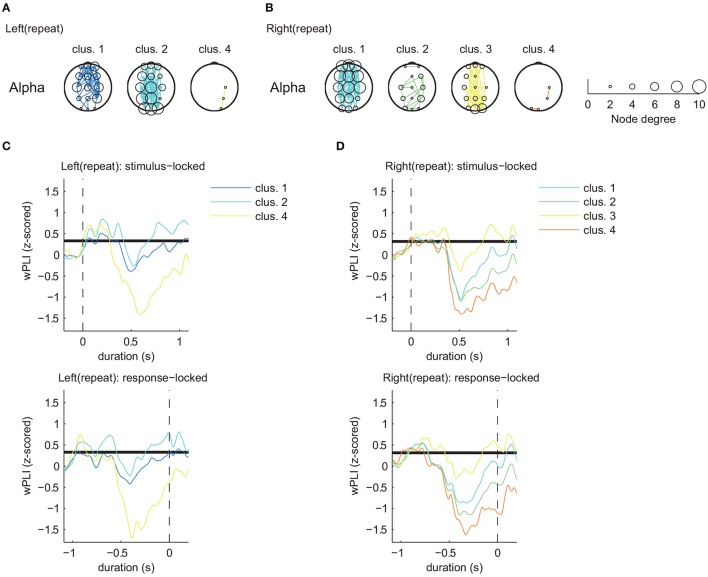
Estimated clusters and functional connectivity based on time series matching of z-scored wPLIs using DTW (MR task: repeat trial, alpha band). (A) Estimated significant clusters of functional connectivity for left repeat trials. Three of five clusters were estimated to be significant. (B) Estimated significant clusters of functional connectivity for right repeat trials. All four clusters were estimated to be significant. Marker size of the electrodes for each topographical location corresponds to the node degree of connectivity. (C,D) Cluster-averaged z-scored wPLIs for each hand in the repeat trials (upper panels: stimulus-locked average; lower panels: response-locked average). Bold black lines indicate a significant level of temporal changes in cluster-averaged value of phase-synchronization (p < 0.05 with FDR correction).